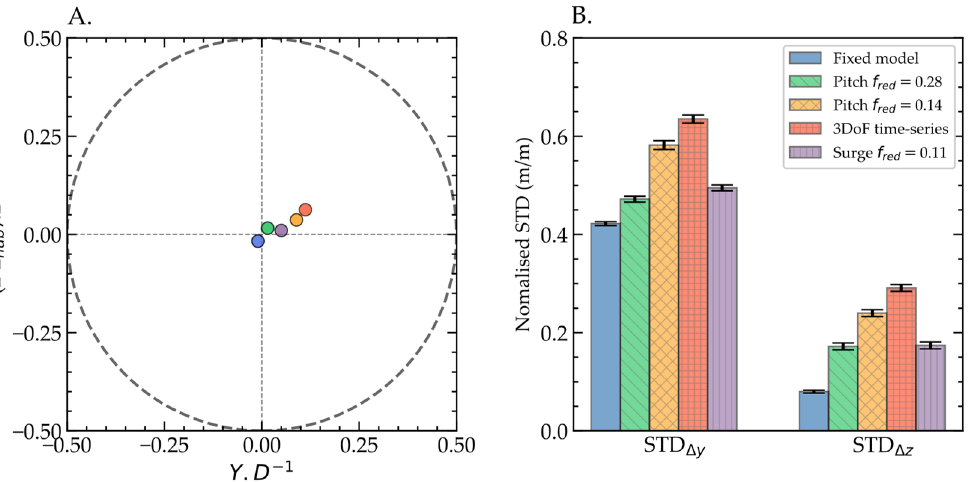
Figure 6. Evolution of the mean wake centres for different test cases at 8.125 D, in lateral and vertical directions: ( A ) Wake centres locations; ( B ) Standard deviations and its 95% confidence interval.